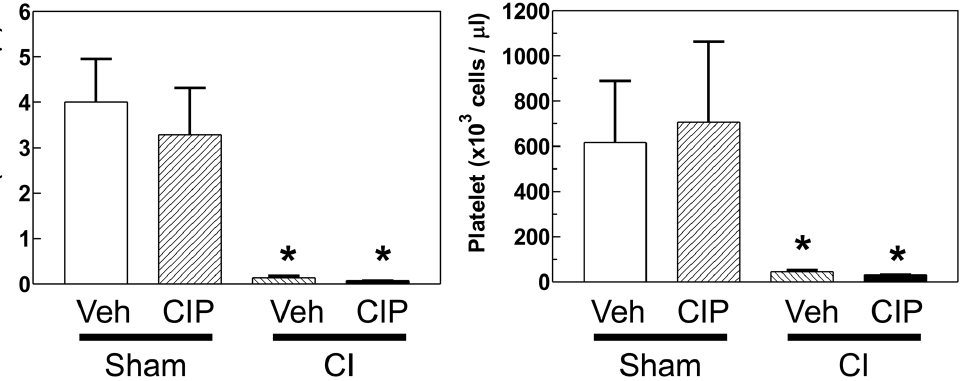
Figure 3. CIP did not ameliorate CI-induced depletion of white blood cells (WBC) and platelets. On day 10 after CI, whole blood was collected from surviving mice and tested for numbers of WBCs and platelets. n=4 2 5 per group; * p , 0.05 vs. sham-Veh, sham-CIP. CI: combined injury; CIP: ciprofloxacin; Veh: vehicle.